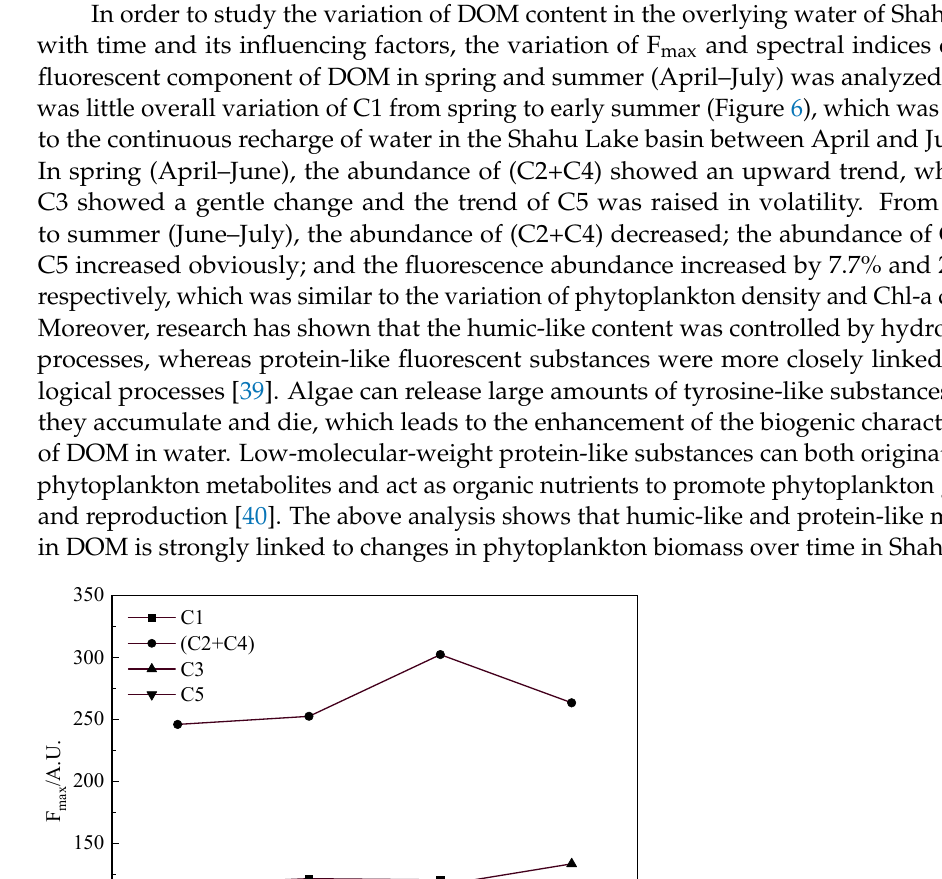
Figure 5. Total fluorescence abundance ( a ) and relative contribution ratio ( b ) of DOM components in the overlying water of Shahu Lake.